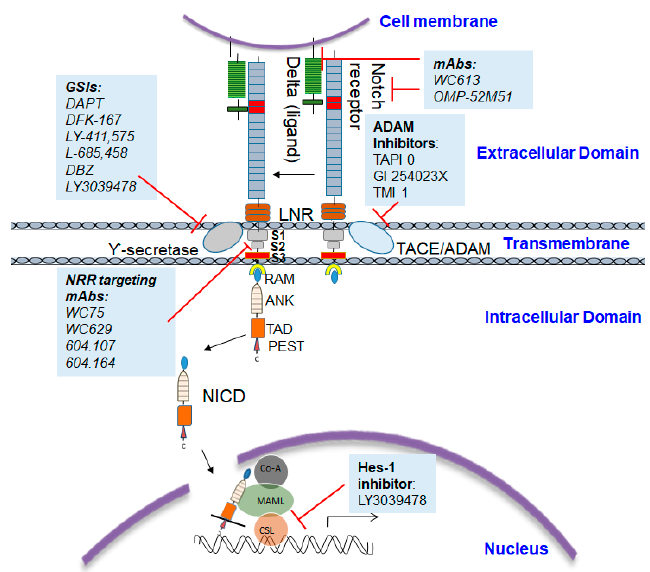
Figure 2. Sites of gamma secretase inhibitors’ (GSIs) binding in γ -secretase: Transition-state analogs such as difluoroketone-167 (DFK-167) bind to catalytic site and small molecule inhibitors such as N -[ N -(3,5-difluorophenacetyl)- L -alanyl]- S -phenylglycine t-butyl ester (DAPT) that bind to sites other than catalytic site.